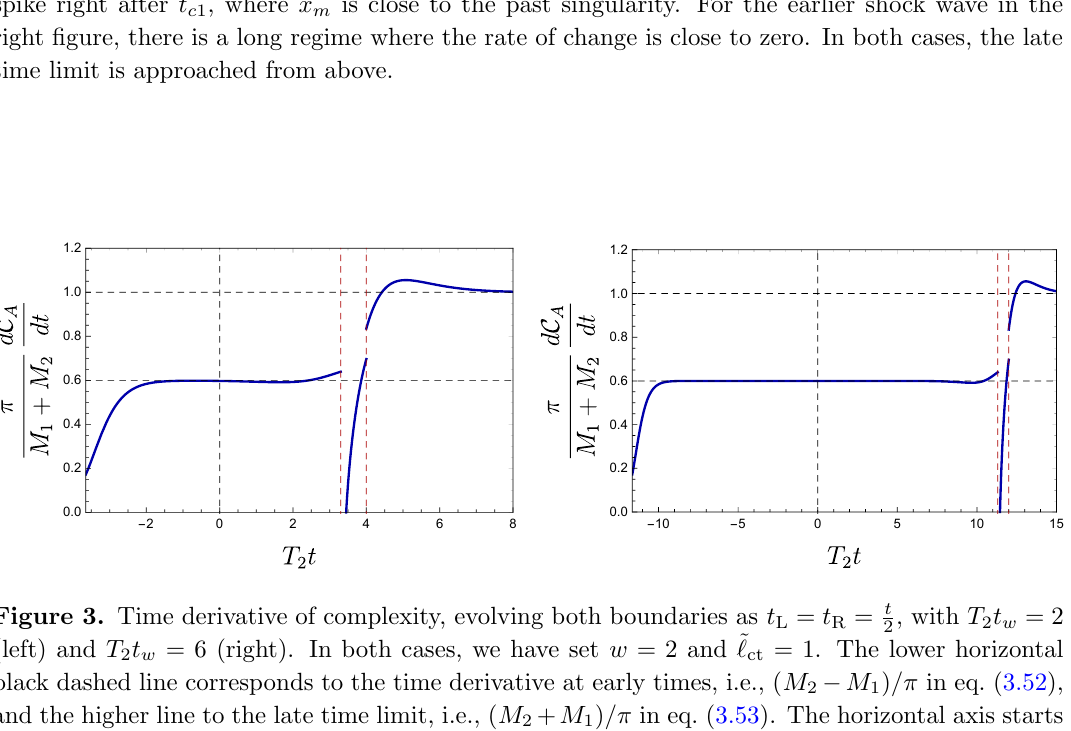
Figure 3. Time derivative of complexity, evolving both boundaries as t (left) and T 2 t w = 6 (right). In both cases, we have set w = 2 and ~ ‘ ct = 1. The lower horizontal black dashed line corresponds to the time derivative at early times, i.e., ( M 2 and the higher line to the late time limit, i.e., ( M 2 + M 1 ) =(cid:25) in eq. (3.53). The horizontal axis starts at t c 0 , and the critical times t c 1 and t c 2 are shown by the left and right vertical dashed red lines, respectively. There is a negative spike right after t c 1 , where x m is close to the past singularity. Pushing the shock wave to the past increases the plateau where the time derivative is given roughly by the di(cid:11)erence of the